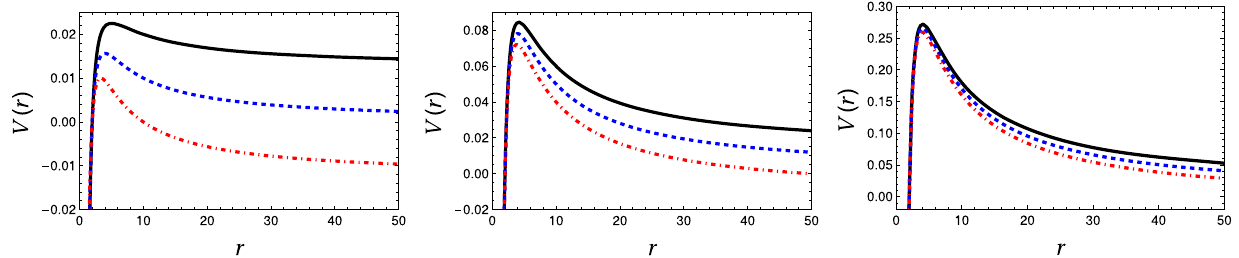
Fig. 1 Effective potential V ( r ) as a function of the radial coordinate r assuming three different values of the parameter m . The panels in the first (left), second (center) and third (right) show V ( r ) for: (1) m = 0 (case 1), (2) m = 1 (case 2) and (3) m = 2 (case 3), respectively. In all